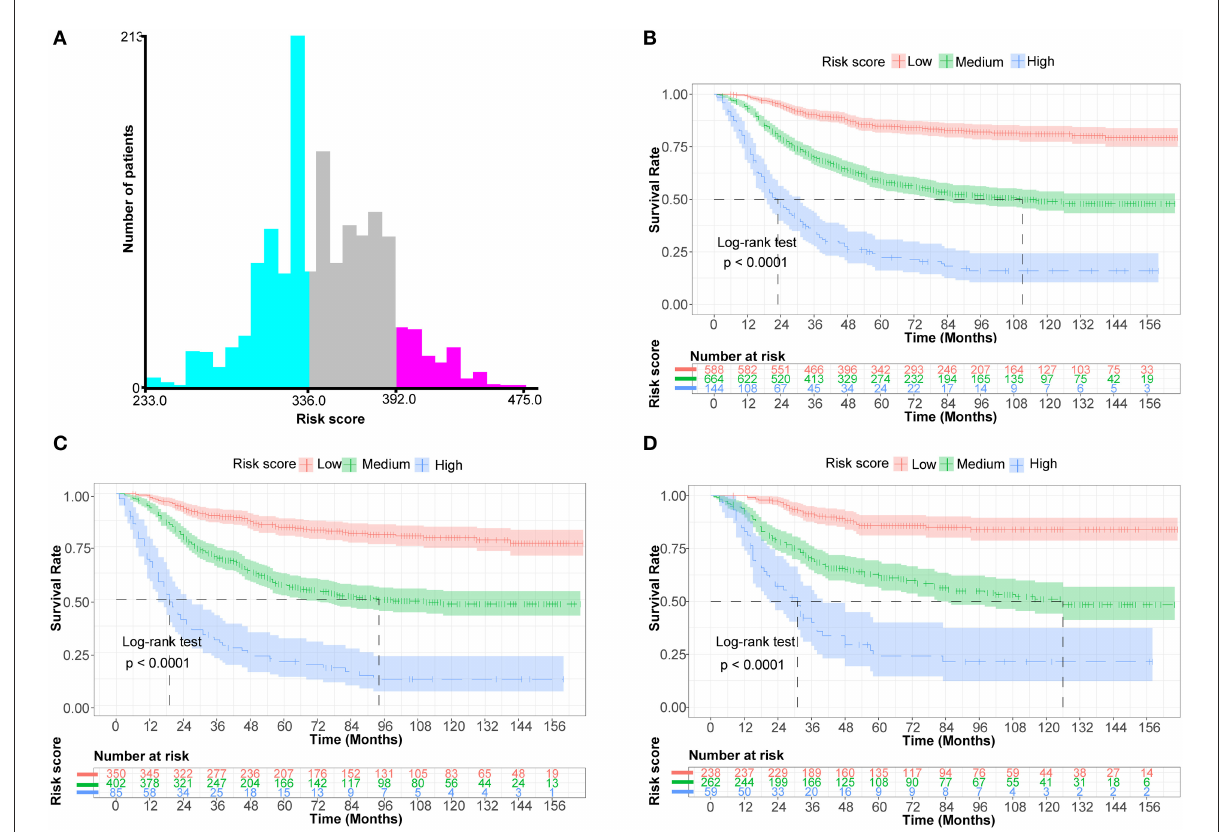
FIGURE5 Establish a risk stratification system by determining the optimal cut-off point for risk scores. (A) Histogram of the distribution of patients based on the optimal cut-off point for risk scores (X-tile software). (B) Prognostic curves among distinct risk groups of all cohorts (the Kaplan-Meier survival analysis). (C) Prognostic curves among different risk groups of the training cohort. (D) Prognostic curves among different risk groups of the validation